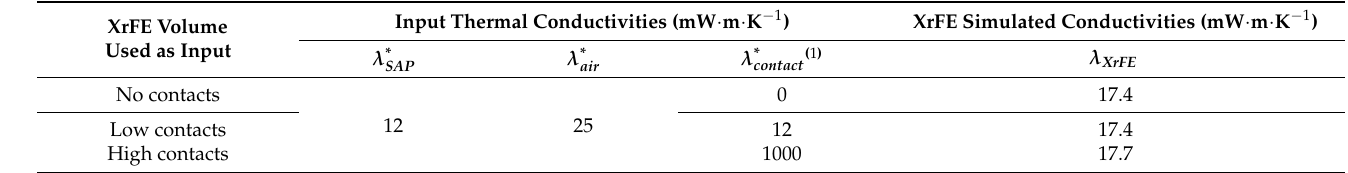
Table 4. Contact parameter study, inputs and XrFE simulated